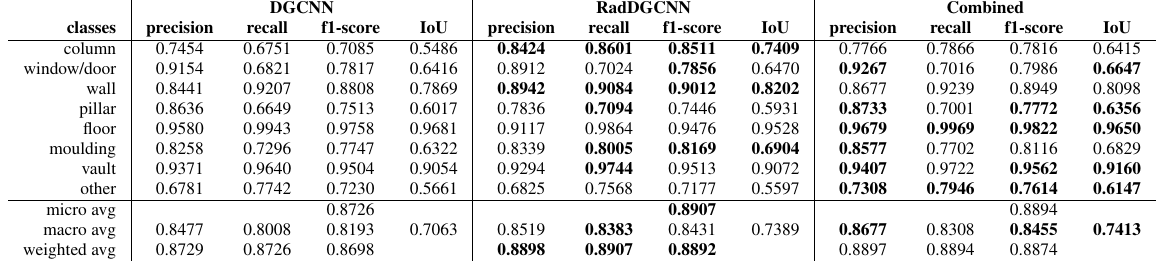
Table 3. Results of the semantic segmentation of the Ducal Palace at Urbino scan.